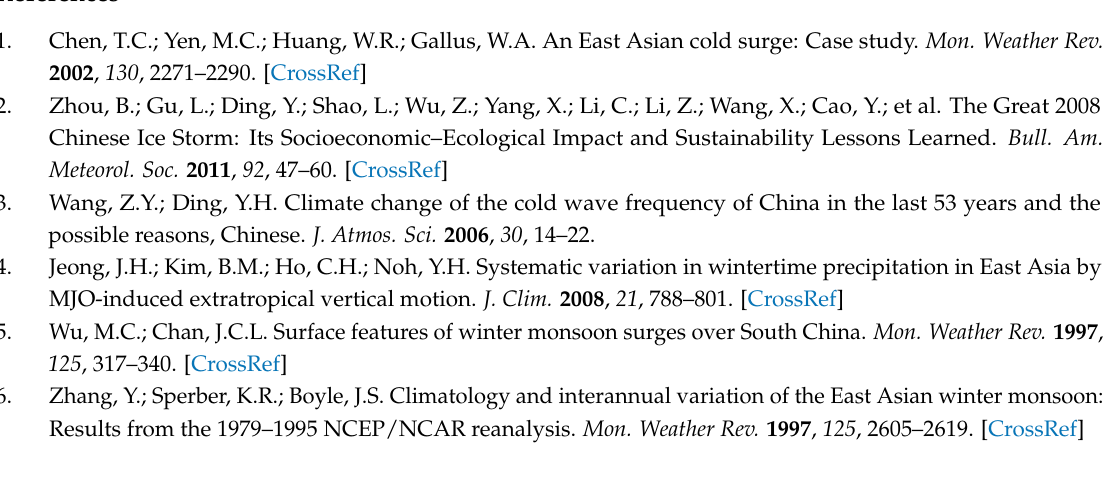
Figure S1: Differences in SH intensification for (a) December; (b) January; and (c) February during the period 1979-2016. Data from the ECMWF ERA Interim, Figure S2: ECMWF, ERA Interim plots for MSLP at 00 UTC on 22nd Jan 2016 showing formation of intense pressure gradient between SH and AL systems, Figure S3: Differences in JS intensity (m/s) at 250 hPa for (a) December; (b) January; and (c) February during the period 1979–2016, Figure S4: (a) Jet Streak intensity at 250 hPa (m/s) and (b) AL intensity (hPa) for Jan 2016 at 00, 06, 12, 18 UTC, Figure S5: Vertical velocity (Pa/s) over the active convection region for Dec, Jan and Feb for the period 1979-2016 from 1000 hPa to 250 hPa computed from ECMWF, ERA Interim, Figure S6: Vertical winds (Pa/s) at from 1000 hPa to 250 hPa along the cross section at 40 0N over active convective region for (a) Dec; (b) Jan; and (c) Feb for the period 1979-2016 computed from ECMWF, ERA Interim, Figure S7: Climatology of winds (m/s) at 250 hPa over active convective region for (a) Dec; (b) Jan; and (c) Feb for the period 1979–2016 computed from ECMWF, ERA Interim, Figure S8: ECMWF, ERA Interim plots for MSLP at 00 UTC for (a) 11th Jan 2016; (b) 15th Jan 2016; (c) 19th Jan 2016; and (d) 25th Jan 2016 showing formation of frequent LPS during Jan 2016 between 140 ◦ E–180 ◦ E and 30 ◦ N–55 ◦ N, Figure S9. ECMWF, ERA Interim plot for MSLP at 00 UTC for (a) 7th Dec 2009; (b) 14th Dec 2009; (c) 18th Dec 2009; and (d) 22nd Dec 2009 showing formation of frequent LPS during Dec 2009 between 140 ◦ E–180 ◦ E and 30 ◦ N–55 ◦ N, Figure S10: ECMWF, ERA Interim plot for MSLP at 00 UTC for (a) 10th Jan 2008; (b) 3rd Feb 2008; (c) 8th Feb 2008; and (d) 13th Feb 2008 showing formation of frequent LPS during Jan–Feb 2008 between 140 ◦ E–180 ◦ E and 30 ◦ N–55 ◦ N, Table S1: Surface temperature anomalies over 2001–2010 with respect